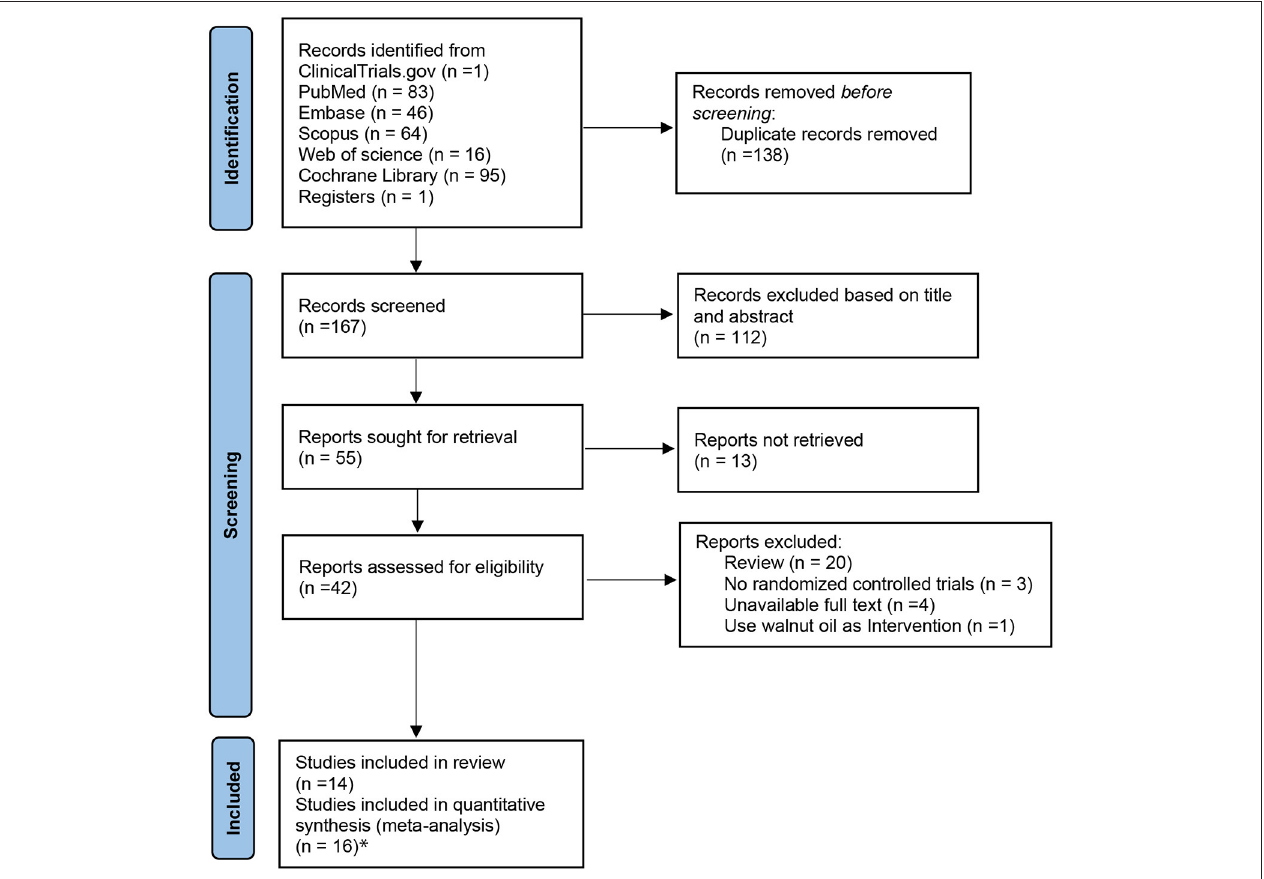
FIGURE 1 | The PRISMA flow diagram of selected trials. Asterisk represents that studies by Jenkins et al. and Lovejoy et al. were each divided into two trials. PRISMA, preferred reporting items for systematic reviews and